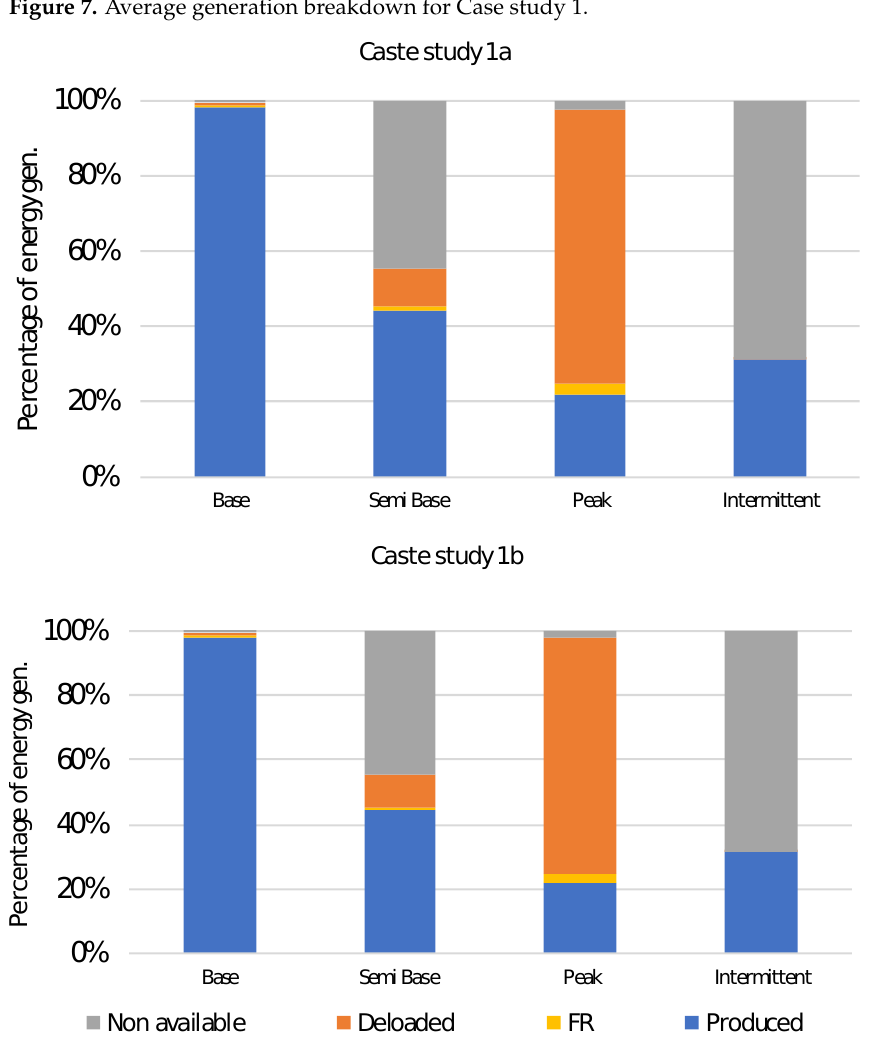
Figure 8. Energy breakdown per technology type for Case study